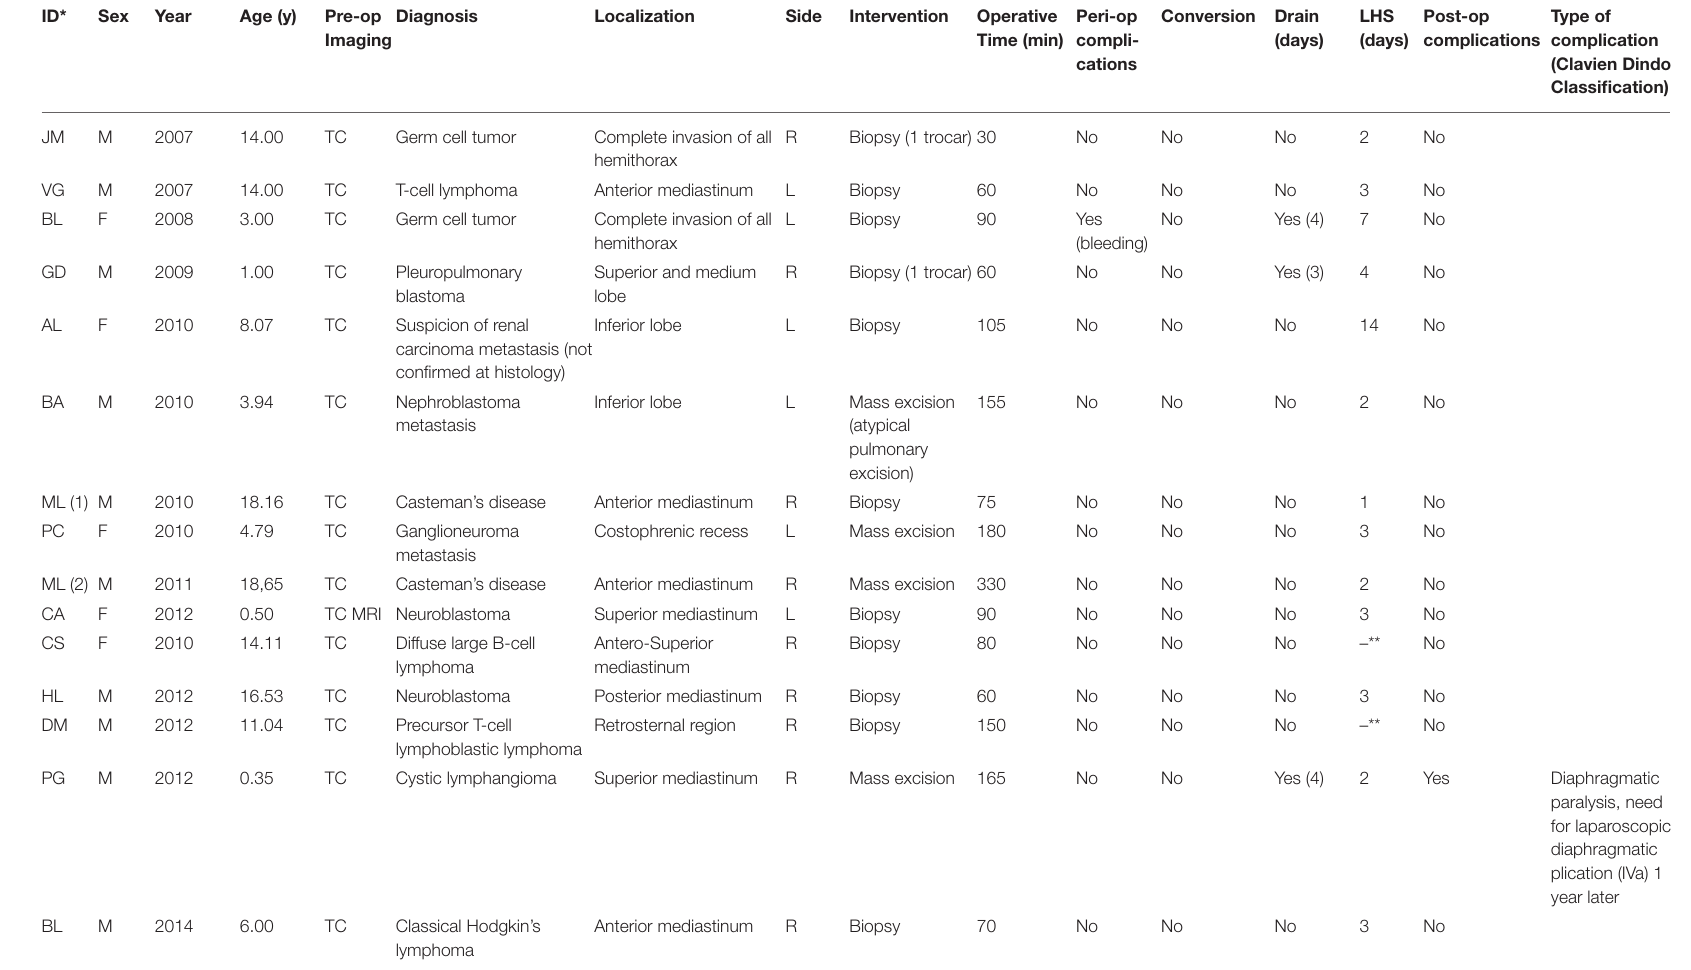
TABLE 1 | Summarized data of all oncological patients undergoing VATS (in chronological